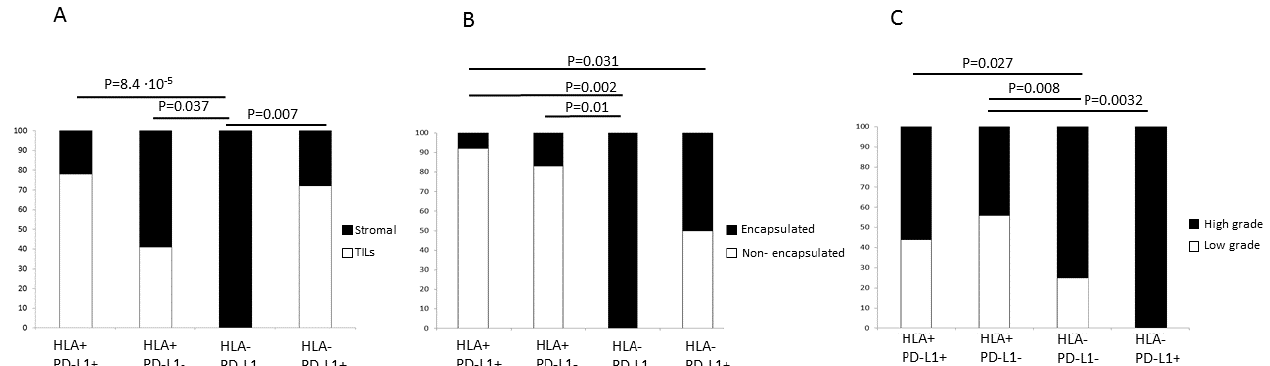
Figure 3. Correlation between HLA-I/PD-L1 tumor phenotype and lymphocyte infiltration ( A ), tumor encapsulation ( B ), and tumor grade ( C ). T-cell exclusion (encapsulated) pattern is typical for HLA-I negative tumors with potentially immunoresistant phenotypes HLA-I-/PD-L1- and HLA-I/-PD-L1+ and an increased presence of FAP-positive stroma cells. Tumors with a diffuse stromal pattern and low FAP expression are mostly positive for HLA-I. C) The majority of high grade tumors are HLA-I negative independently of the PD-L1 status. p -values were obtained using chi-square test with IBM SPSS Statistics Ver.21.0 software. Differences between different groups were considered statistically significant at p < 0.05.